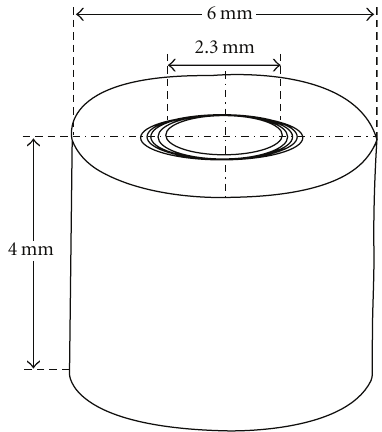
Figure 1: Schematic view of used dentin tubes (adopted from Mohammadi and Shahriari